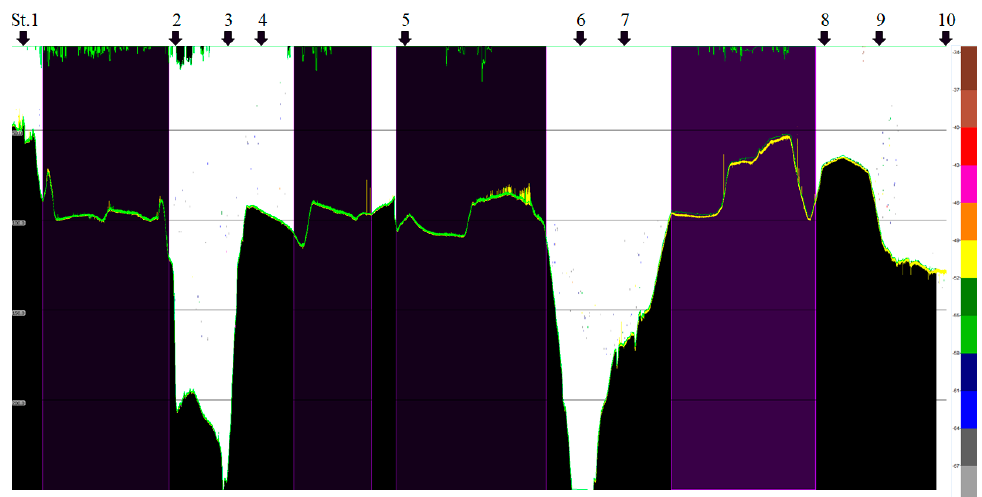
Figure 8. Vertical distribution of pacific cod.